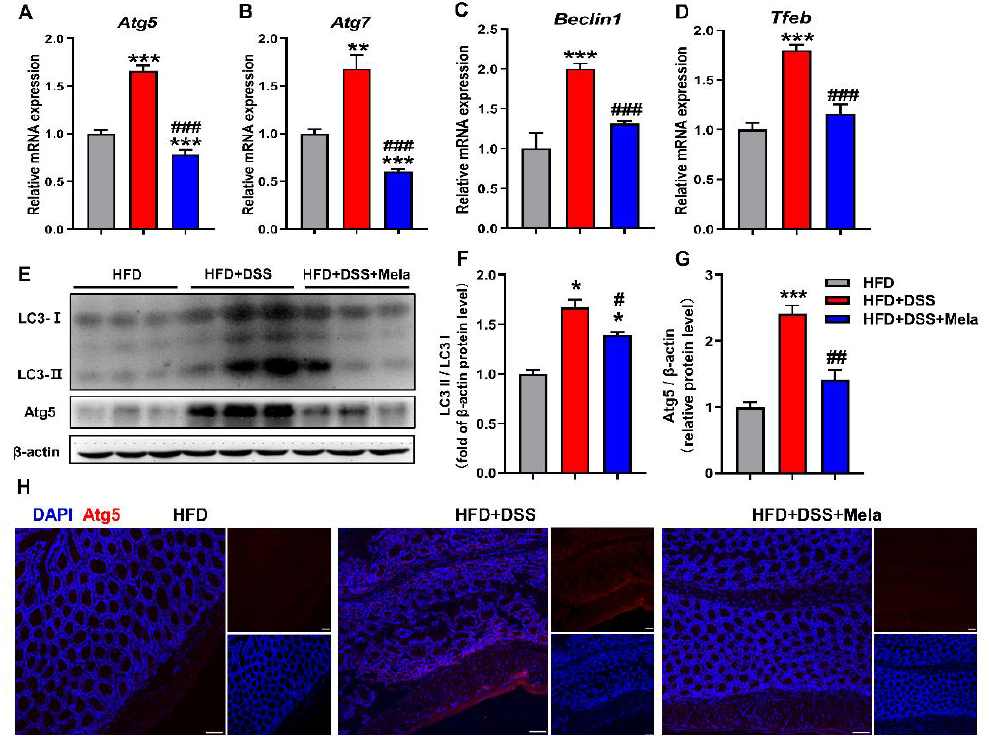
Figure 7. Melatonin mediates adipocyte-induced autophagy in DSS-treated obese mice. ( A – D ) Colonic mRNA expression of genes involved in autophagic genes ( Atg5 , Atg7 , Beclin1 , and Tfeb ) was measured by real-time PCR analysis. ( E – G ) The LC3II/I and Atg5 protein levels were examined in the colon. ( H ) Immunofluorescence of Atg5 ( red ) and DAPI ( blue ) in colon sections (scale bar = 50 µ m). Data in the graphs represent mean ± SEM. n = 10. Significant differences are shown by * p < 0.05, ** p < 0.01, *** p < 0.001 compared with HFD; # p < 0.05, ## p < 0.01, ### p < 0.001 versus HFD + DSS.